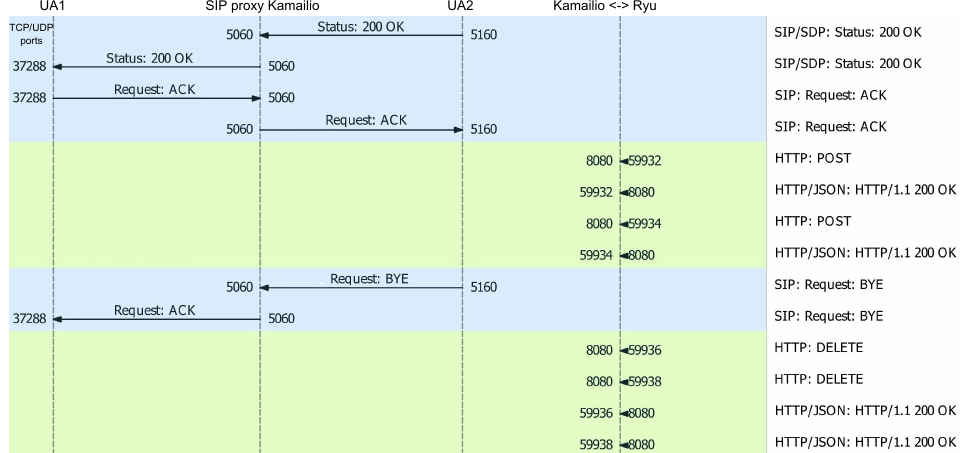
Figure 2. Session initation protocol (SIP) flowchart in